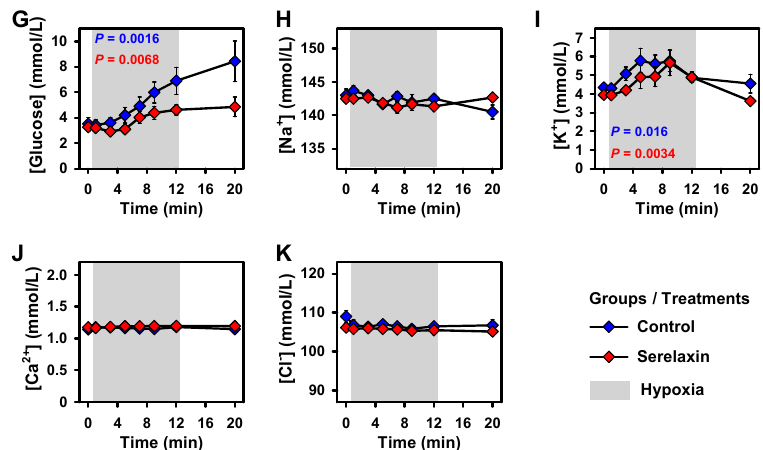
Figure 1. Effects of hypoxia and reoxygenation on blood parameters. Values are given for baseline ( t = 0 min), during hypoxia (up to t = 12 min), and after reoxygenation ( t = 20 min) in controls and the serelaxin-treated group. ( A ) pH, ( B ) partial pressure of carbon dioxide (pCO 2 ), ( C ) pO 2 , ( D ) sO 2 , ( E ) base excess (BE), ( F ) lactate, ( G ) glucose and ( H ) sodium, ( I ) potassium, ( J ) calcium, and ( K ) chloride. Mean ± SEM; p -values for changes during hypoxia result from linear mixed models.